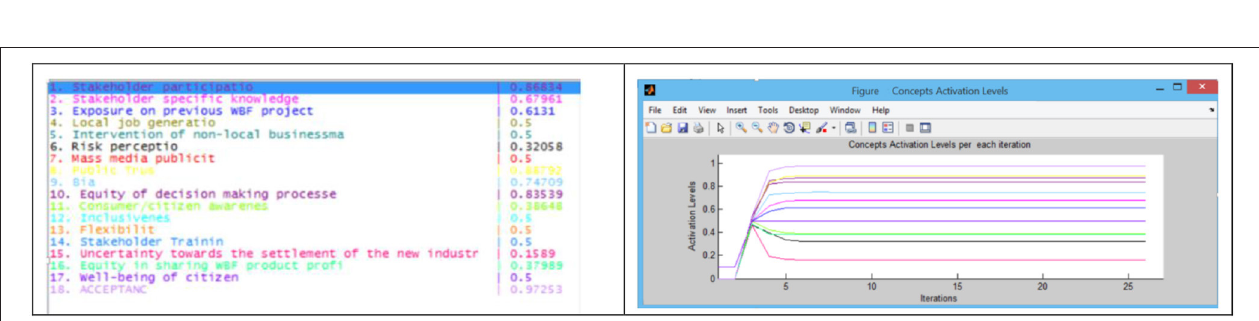
FIGURE 8 | Converged concept values and activation curves for the worst case scenario of the Social_FCM.